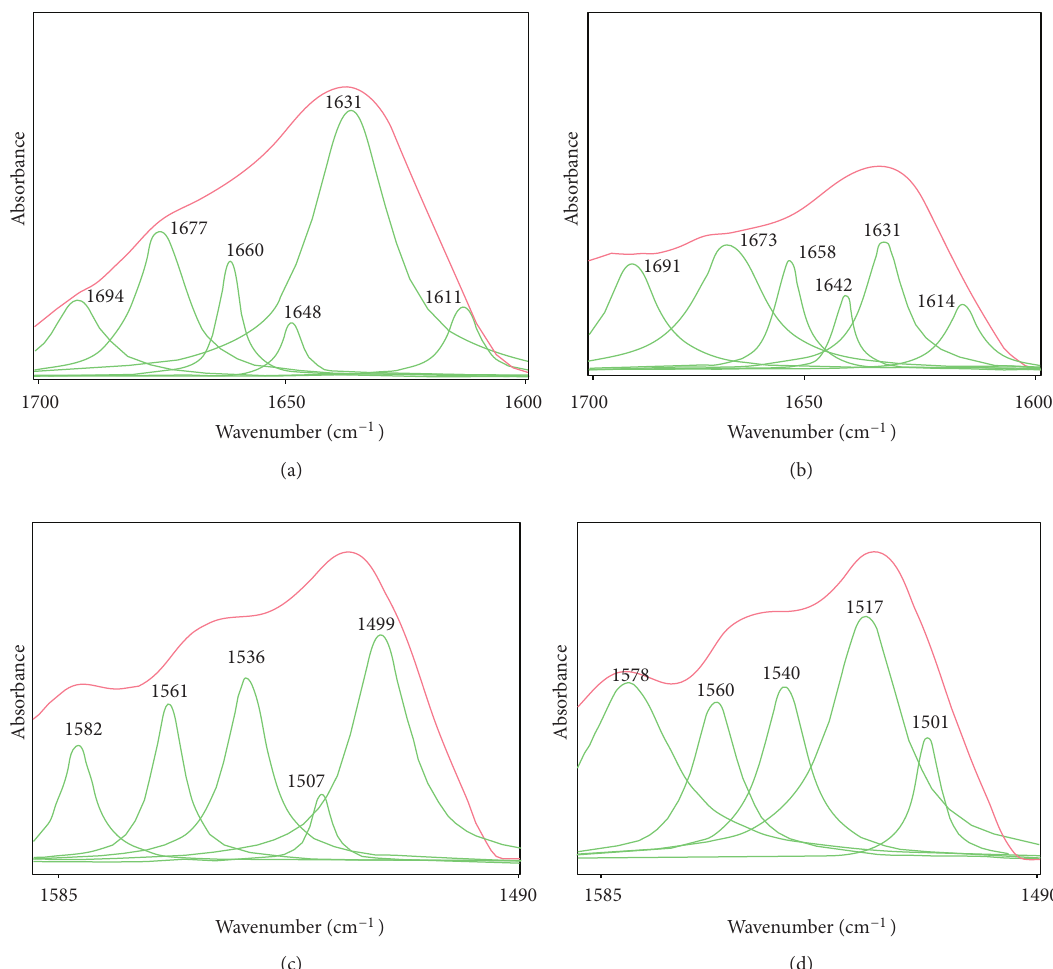
F 6: �ur�e-�tted graphs for (a) free TTR in amide I region, (b) TTR-pentobarbital complex with 0.96mM pentobarbital concentrations in amide I region, (c) free TTR in amide II region, and (d) TTR-pentobarbital complexes with 0.96mM pentobarbital concentration in